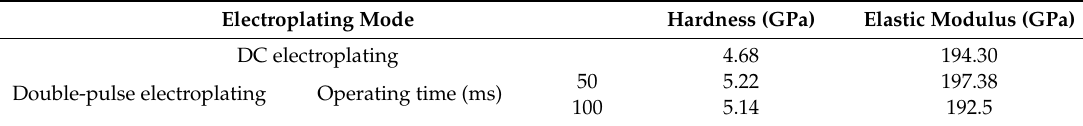
Table6. Hardnessandelasticmodulusofcompositecoatingspreparedbydi ff